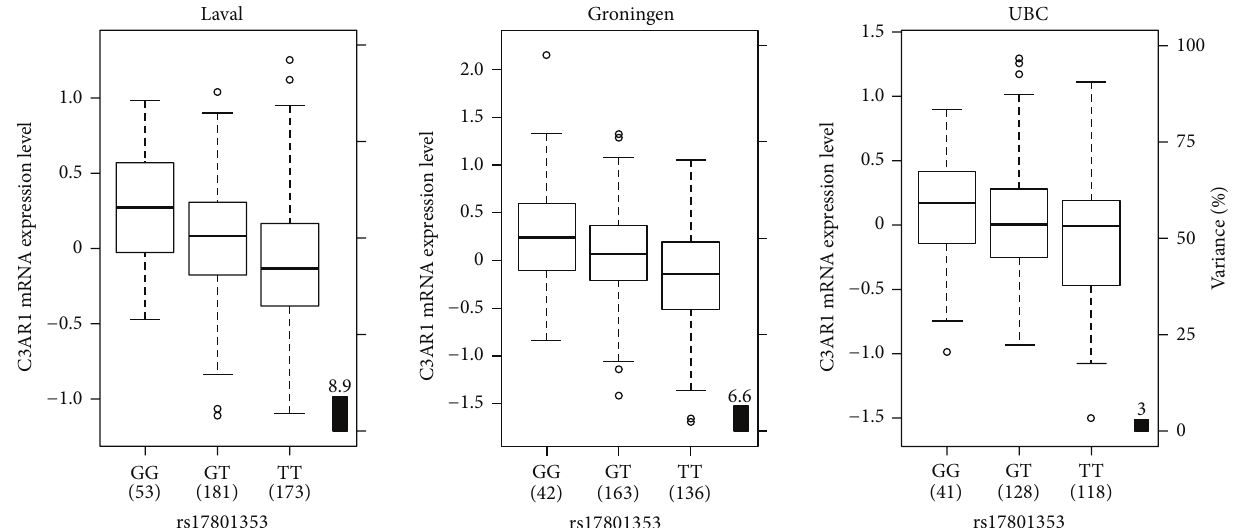
Figure 3: Boxplots of lung mRNA expression levels for C3AR1 according to genotype groups for SNP rs17801353 in lung tissues from Laval ( 𝑛 = 407 ), Groningen ( 𝑛 = 341 ), and UBC ( 𝑛 = 287 ). The right 𝑦 -axis shows the proportion of the gene expression variance explained by the SNP (black bar). The 𝑥 -axis represents the three genotyping groups for SNP rs17801353 with the number of subjects in